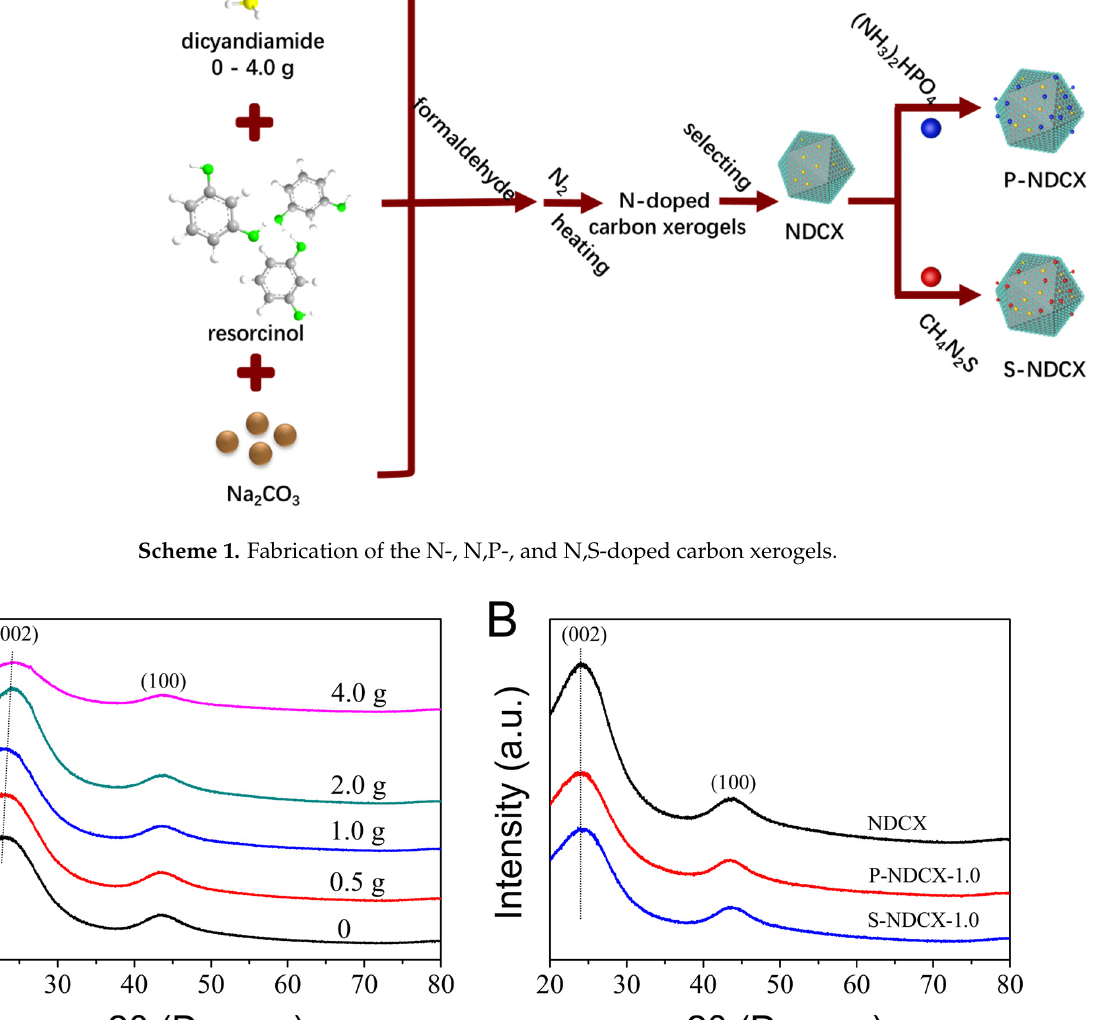
Figure 1. XRD patterns of ( A ) N ‐ doped carbon xerogels prepared with 0–4.0 g of dicyandiamide and ( B ) NDCX, P ‐ NDCX ‐ 1.0, and S ‐ NDCX ‐ 1.0.